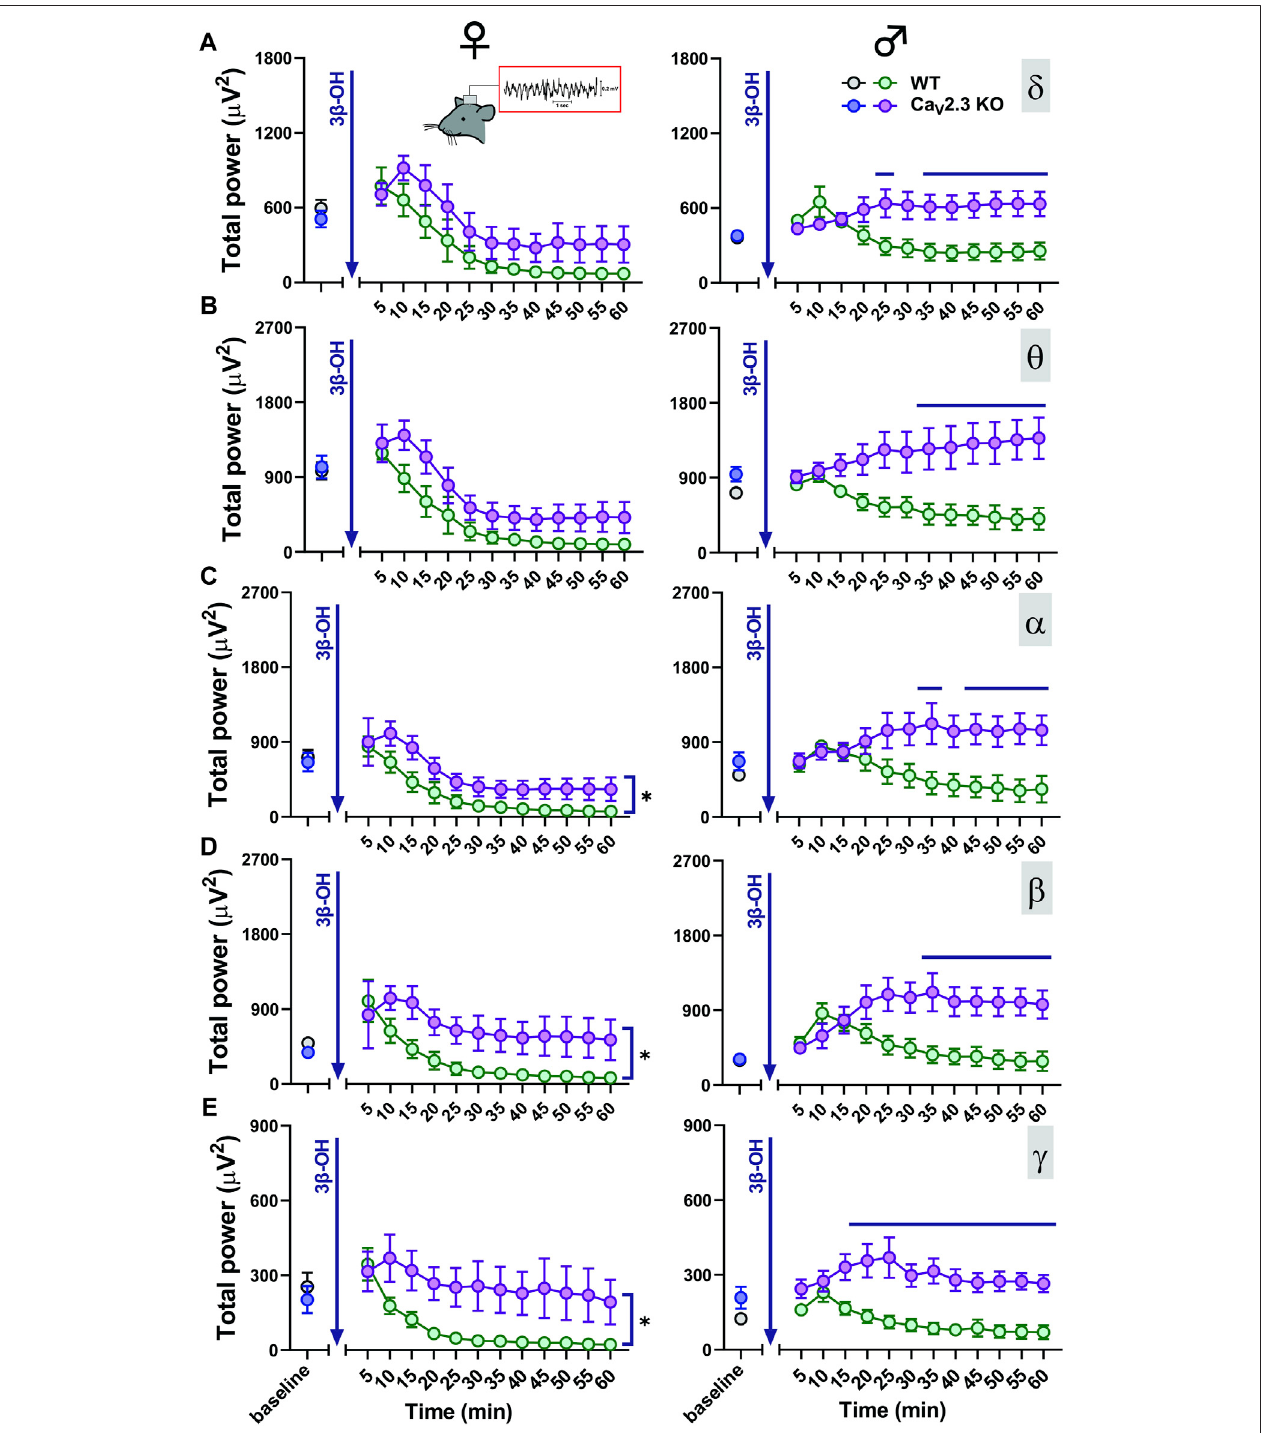
FIGURE5| TotalEEGpowerafteri.p.injectionsof80 mg/kgof3 β -OHduringthetimecourseof60 mininWT(black,baseline;green,3 β -OH)andCa V 2.3KO(blue, baseline; purple, 3 β -OH) animals in the females isdepicted on the left; in the males, this ispresented on the right. Total δ (A) , θ (B) , α (C) , β (D) , and low γ (E) power after 3 β -OHinjectioninfemalesandmales. (A) Left,two-wayRMANOVA:interactionF 11,88 =0.60, p =0.823;genotypeF 1,8 =3.39, p =0.103;timeF 11,88 =15.72, p < 0.001. (B) Left, two-way RM ANOVA: interaction F 11,88 = 0.72, p = 0.715; genotype F 1,8 = 4.57, p = 0.065; time F 11,88 = 31.56, p < 0.001. (C) Left, two-way RM ANOVA: interaction F 11,88 = 0.48, p = 0.910; genotype F 1,8 = 6.64, p = 0.033; time F 11,88 = 17.34, p < 0.001. (D) Left, two-way RM ANOVA: interaction F 11,88 = 1.03, p = 0.430; genotype F 1,8 = 9.54, p = 0.015; time F 11,88 = 5.54, p < 0.001. (E) Left, two-way RM ANOVA: interaction F 11,88 = 1.82, p = 0.065; genotype F 1,8 = 7.94, p = 0.022; time